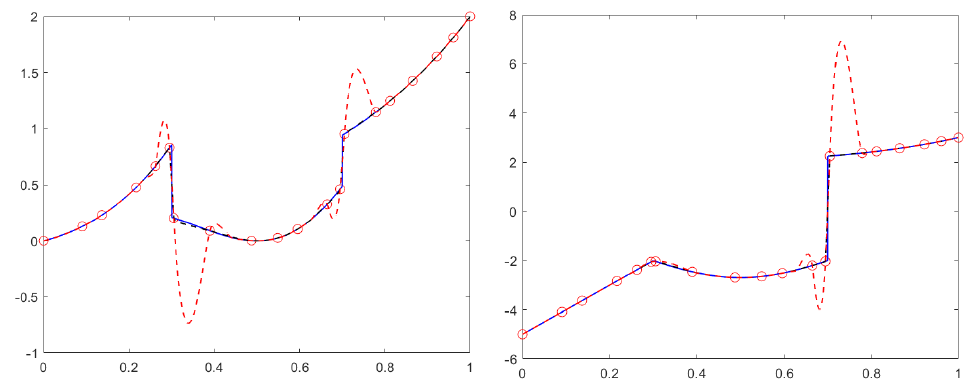
Figure 1. ( Left ) Comparison of the subdivision curve after k = 5 subdivision levels for the Lagrange subdivision scheme in a dashed red line and the PPH subdivision scheme in a dash-dotted black line. The original function f ( x ) is also plotted in a solid blue line. The initial control points, plotted with red circles, come from one of the nonuniform grids X considered in our two experiments, the one that consists of 30 abscissas in the interval [ 0,1 ] . ( Right ) Zoom of the area around the first jump discontinuity.